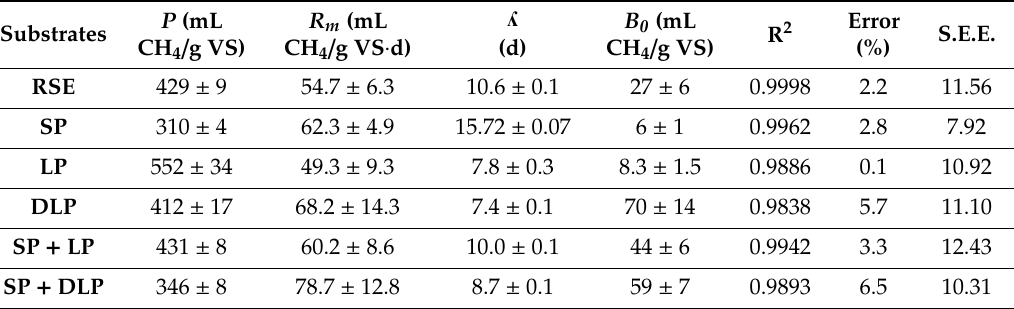
Figure 3. ( A ): Variation of cumulative methane production (mL CH 4 / g VS) (VS, total volatile solids) with time for LP (liquid phase), SP (solid phase), and DLP (dephenolized liquid phase) after 170 °C hydrothermal treatment with their standard deviations; ( B) : Variation of cumulative methane production (mL CH 4 /g VS) with time for the untreated RSE (residual strawberry extrudate), SP + LP and SP + DLP mixtures after 170 °C hydrothermal treatment with their standard deviations. Table 3. Values of the parameters obtained from the logistic model (sigmoidal 4 parameters) for the different substrates and mixtures studied (hydrothermal treatment at 170